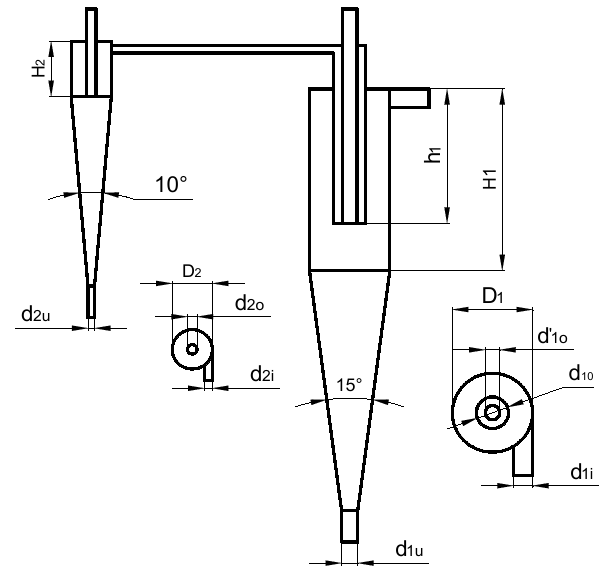
Figure 1. Schematic diagram of multi-product hydrocyclone.